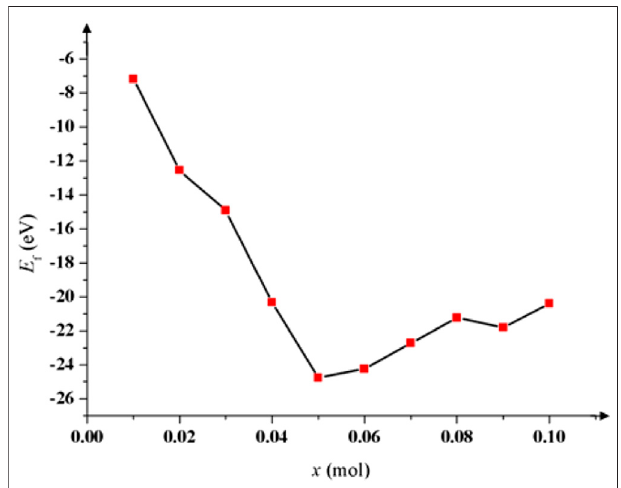
FIGURE 4 | Formation energy of intercalation of Li + with different doping amount x of Na. When x (cid:2) 0.05 mol, E f is lowest and the cycling performance is